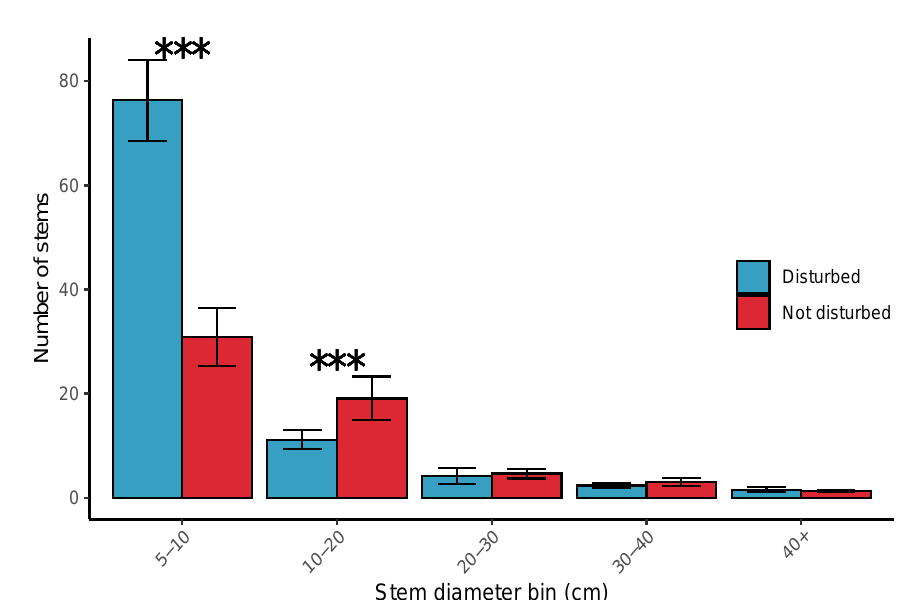
Figure 8. Ranked variation between disturbed and undisturbed plots in stem number, with bars according to stem diameter class. Error bars are the mean ± 1 standard error. Asterisks above pairs of bars refer to the p -values of Poisson general linear models which tested whether disturbed and undisturbed plots differ in the number of stems for different stem diameter classes (*** <0.001, ** <0.01, * <0.05, .